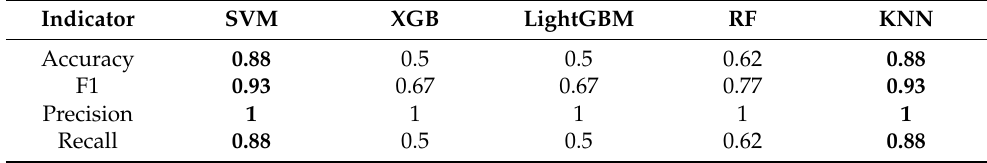
Table 3. High Risk Predictive Model Evaluation Results.